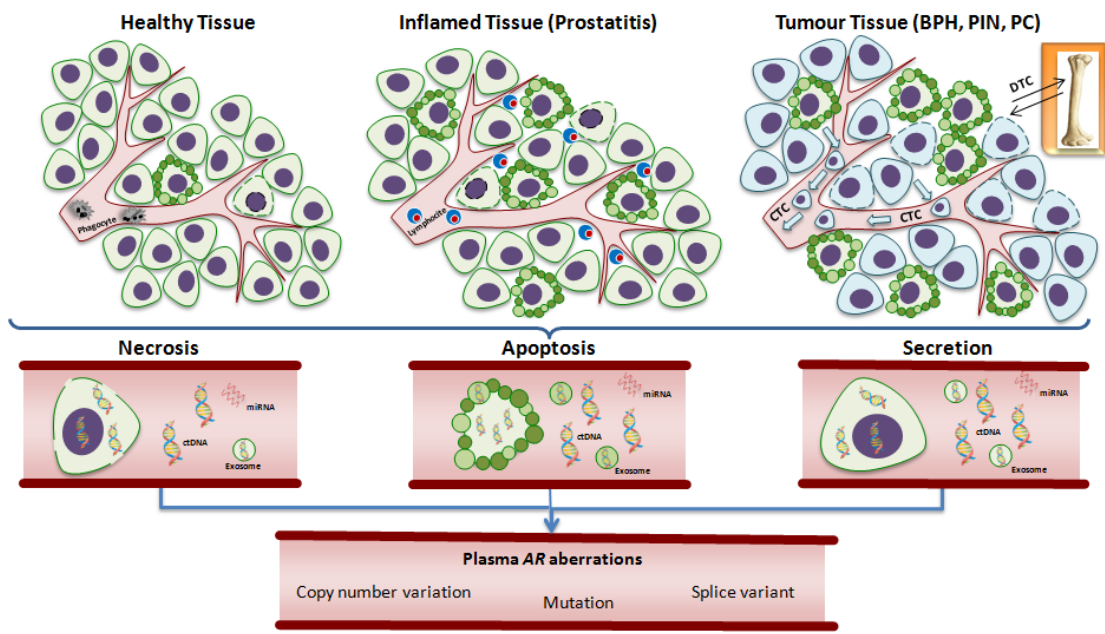
Figure 2 . Biology of circulating free DNA. Circulating free DNA (plasma DNA) is released from the cells of healthy, inflamed, or tumor tissue undergoing apoptosis or necrosis, or, more rarely, from living cancer cells that actively release DNA into the circulation because of oncogenic properties. Certainly, levels of plasma DNA are also under the control of the activity of infiltrating phagocytes that usually clear apoptotic and necrotic debris and pro-apoptotic cytokines released by inflammatory cells (e.g., lymphocytes) or cancer cells. Circulating DNA may also be released by CTCs shed by the tumor and by DTC into bone marrow. The analysis of plasma DNA, together with other circulating nucleic acids in the bloodstream, such as miRNA and exosomes, has led to the identification of several genetic and epigenetic alterations of tumor, including circulating aberrations of androgen receptor such as copy number variation, mutations and splice variants. Abbreviations: AR, androgen receptor; BPH, benign prostatic hyperplasia; ctDNA, circulating tumor DNA; CTC, circulating tumor cell; DTC, disseminated tumor cell; miRNA, microRNA; PC, prostate cancer; PIN: prostatic intraepithelial neoplasia.